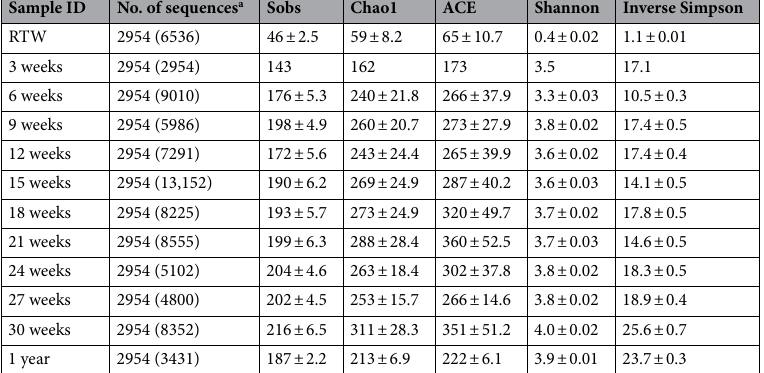
Table 1. Bacterial species richness (ACE and Chao1) and diversity indices (inverse Simpsons and Shannon– Wiener) calculated from NGS data. a Numbers in parentheses stand for the total number of sequences obtained with NGS; for calculating richness estimators and diversity indices, read numbers were subsampled to the read number of the sample having the lowest sequence count.